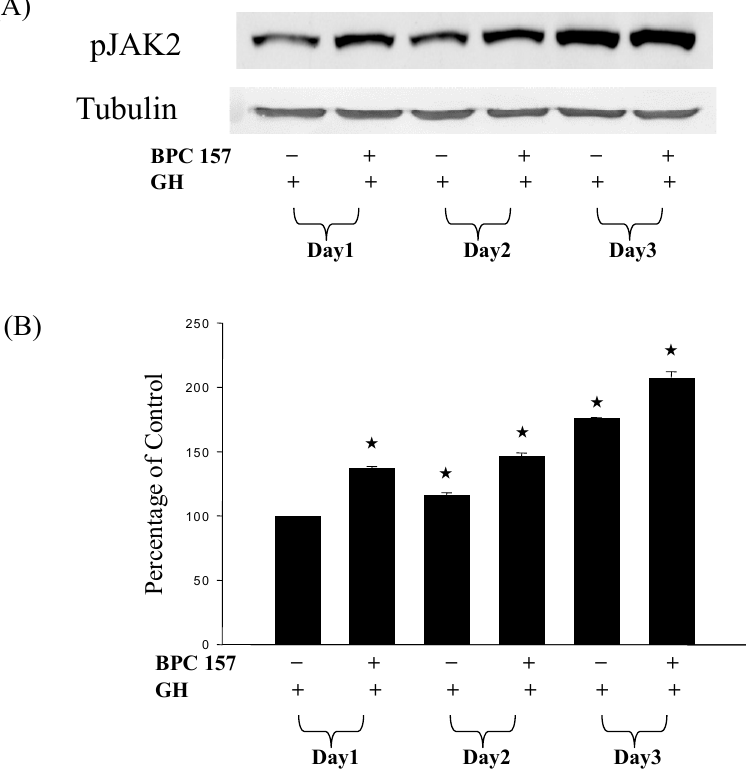
Figure 4. Growth hormone activated more JAK2 proteins in BPC 157-treated tendon fibroblasts. Tendon fibroblasts at 50%–60% confluency were pretreated with BPC 157 at concentration of 0.5 μ g/mL for one to three days. After BPC 157 pretreatment, 0.1 μ g/mL growth hormone was added for another 24 h and then total JAK2 (which was not shown) and activation of JAK2 which was determined by the level of phosphorylated JAK2 were detected by Western blot analysis ( A ). Experiments were done in triplicate. The levels of phosphorylated JAK2 were calculated by direct densitomeric analysis of the blot ( B ). The “ ★ ” would be applied if there is statistically